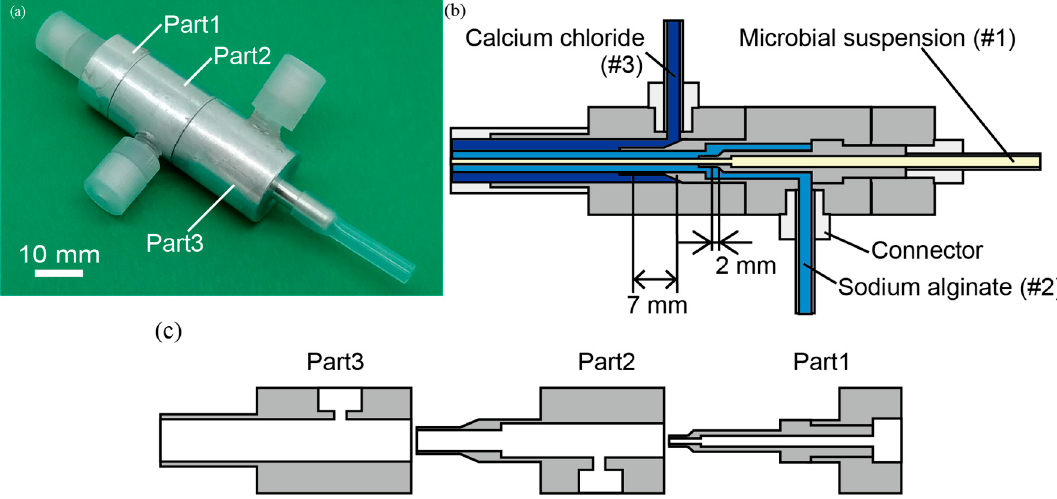
Figure 3. Triple-coaxial flow device. ( a ) Image of the device. Cross-sectional view of ( b ) the device and ( c ) the three parts to produce the triple-coaxial flow.